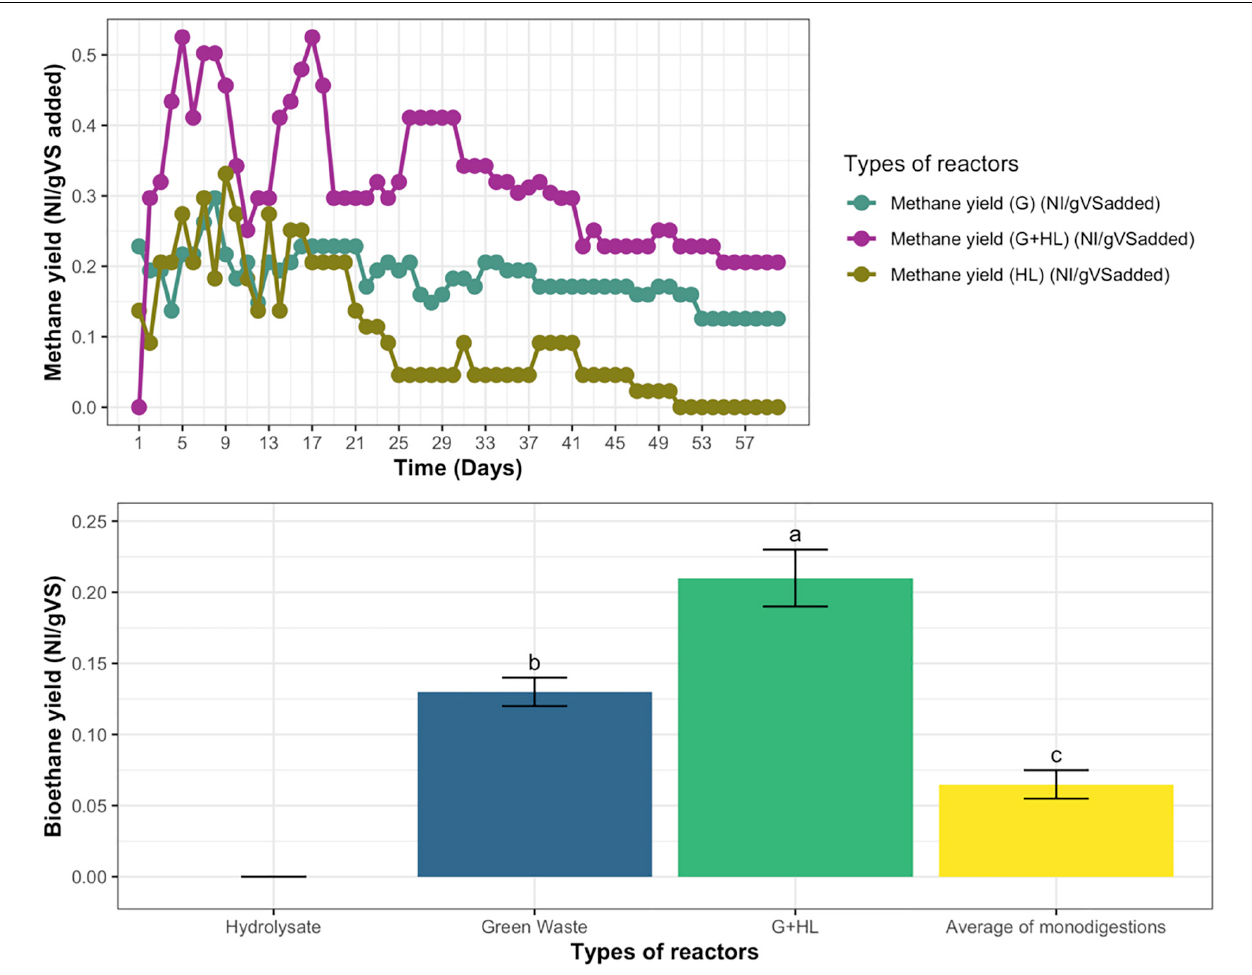
FIGURE 6 | (A) Daily biomethane yield of hydrolysate (HL), green waste (G), and their co-digestion (G+H). (B) Biomethane yield of co-digestion compared with an average of mono-digestions for continuous anaerobic fermentation. Means having the same letter are statistically similar as per the Tukey test at p <